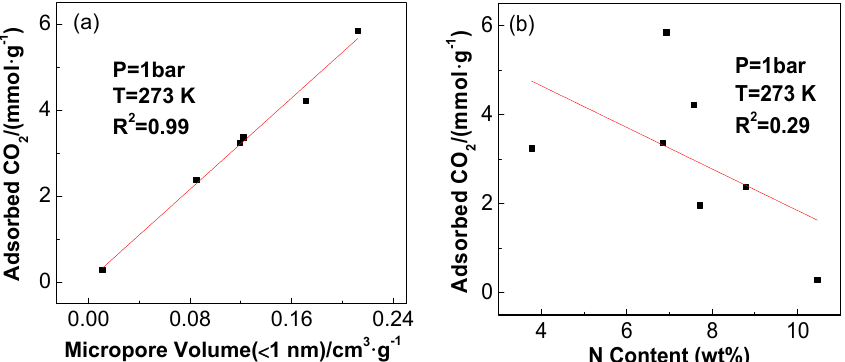
Figure 10. Correlation of CO 2 adsorption capacity with ultra - micropore volume ( a ) and with sample N content ( b ) at 273 K.